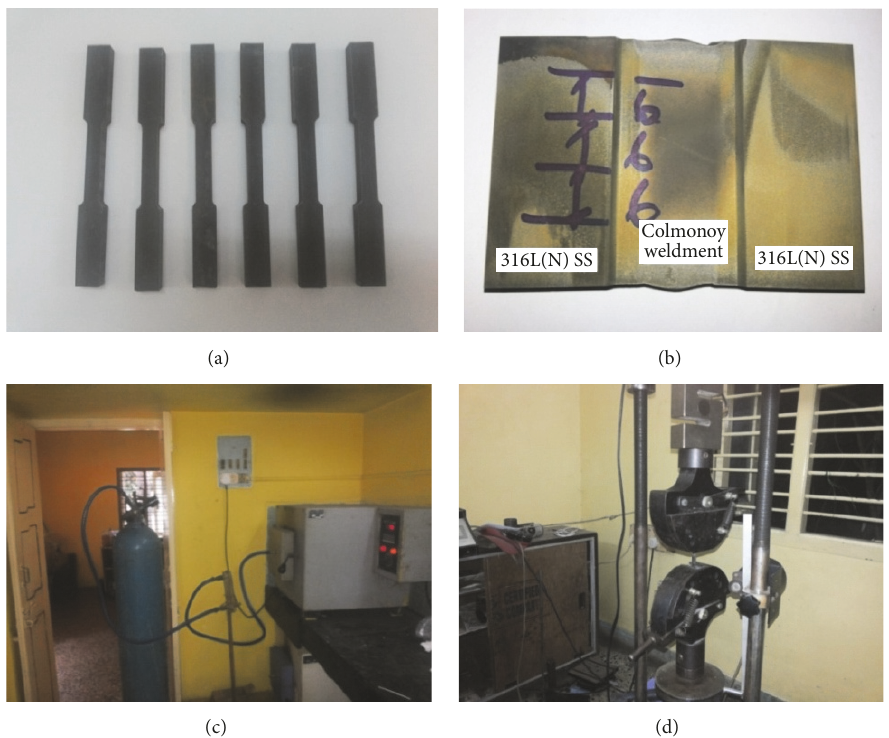
Figure 3: (a) Some of the samples of parent metal. (b) Welded plate for tensile test specimens. (c) Stress relieving procedure. (d) Tensile test setup for room temperature